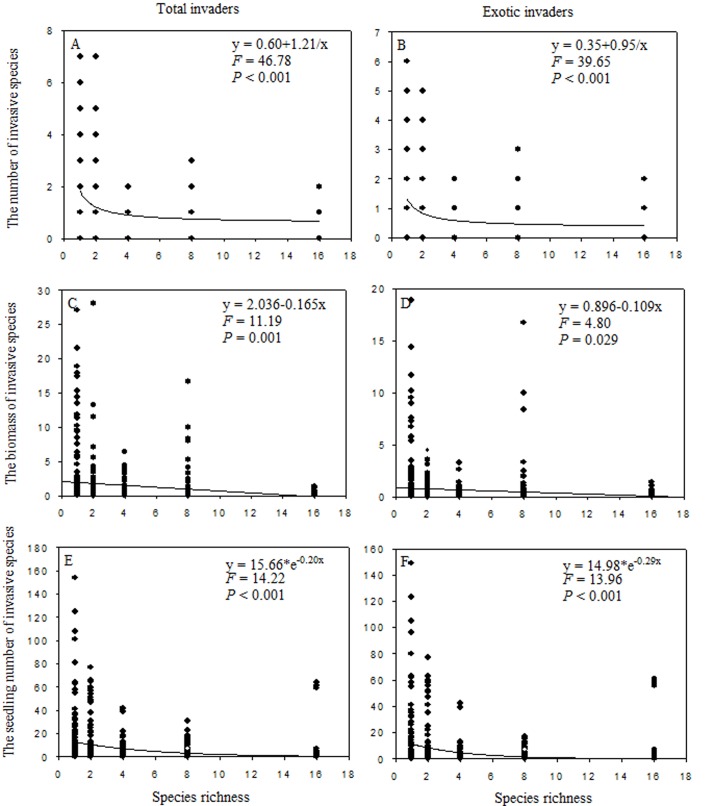
The dependence of species number (A, B), biomass (C, D) and seedling number (E, F) of total and exotic invaders on species richness.